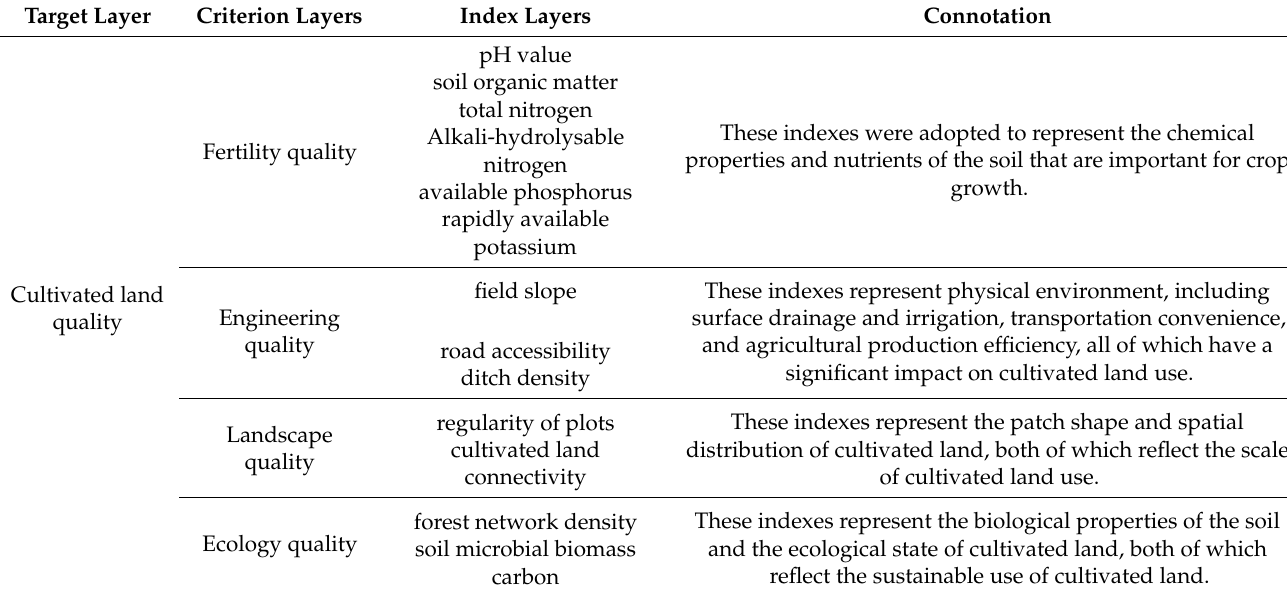
Table 1. Evaluation index system for cultivated land